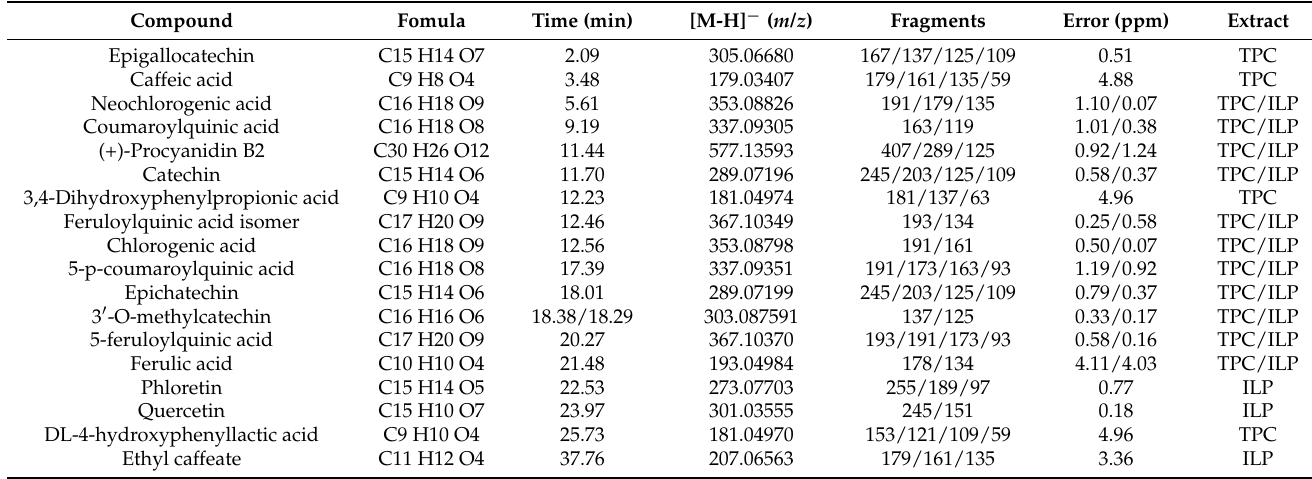
Table 4. Phenolic compounds identified in extracts obtained under optimal conditions for the highest total phenolic content (TPC, 1.1% EtOH) and the inhibition of lipid peroxidation (ILP, 76.4% EtOH). Compound Fomula Time (min) [M-H] − ( m/z